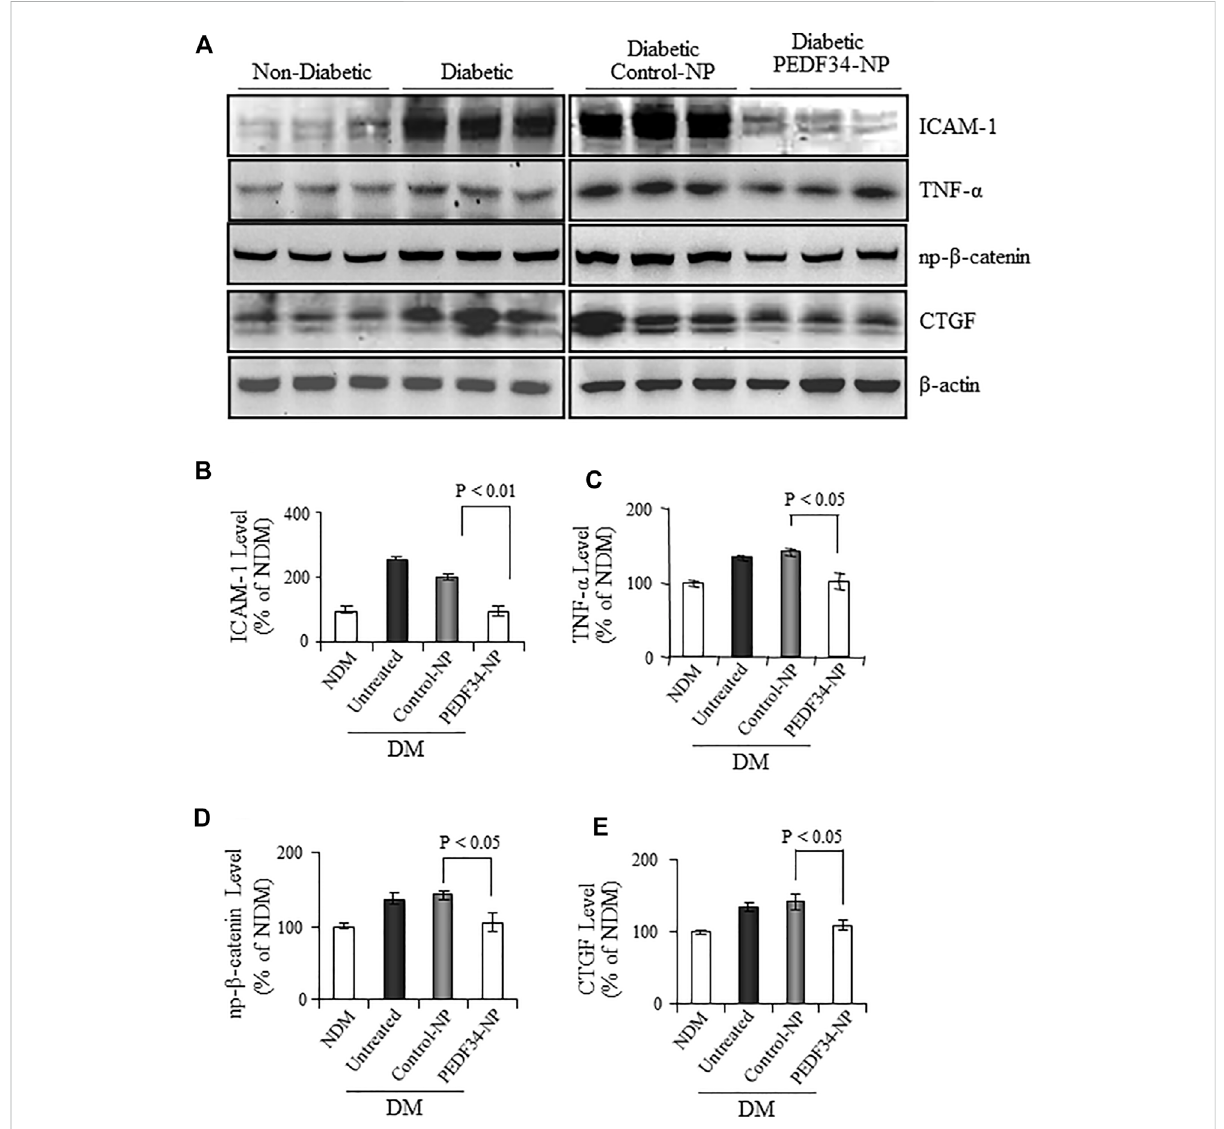
FIGURE 5 PPEDF34-NP decreased retinal levels of non-phosphorylated β -catenin (NP- β -catenin), in fl ammatory, and fi brogenic factors in STZ-induced diabetic rats. Diabetic rats received an intravitreal injection of 5 μ g of PEDF34-NP or Control-NP. (A) Four weeks after the injection, retinal levels of ICAM-1,TNF- α NP- β -catenin,andCTGFweredeterminedbywesternblotanalysis.PEDF34-NPsigni fi cantlyreducedthelevelsofICAM-1 (B) ,TNF- α (C) ,NP- β -catenin (D) ,andCTGF (E) intheretinal tissue.Theproteinslevelsweresemi-quanti fi edbydensitometry,normalizedby β -actinlevels, and expressed as % of those in non-diabetic rat retinas (mean ± SD, n